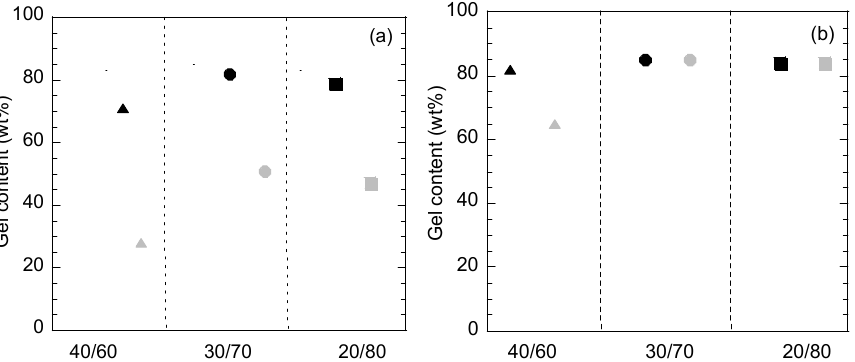
Figure 5. The gel content of sugar-based latexes prepared with different MF/BA ratios at 1 wbm% KPS ( ▲ ● ■ ) and 0.5 wbm% KPS ( ▲ ● ■ ). ( a ) Initial measurements; ( b ) Measurements repeated after 15 days.